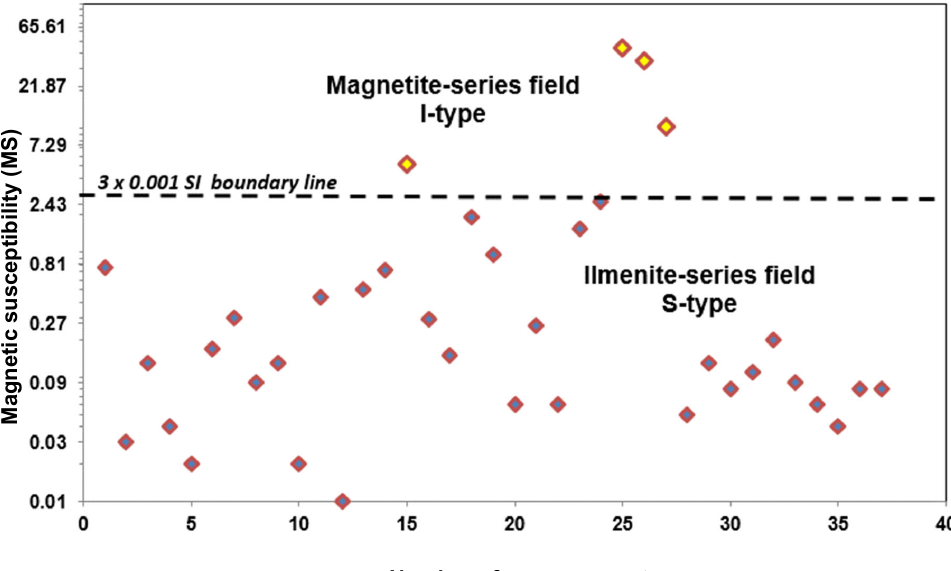
Figure 17. Spider plot of magnetic susceptibility (MS) measurements for the granitic samples collected in the study area. The dotted line sits at the value of 3 × 10 − 3 SI discriminating the I-type and S-type granites. All I-type samples plot above the line 3 × 0.001 SI and the S-type samples plot below the line 3 × 0.001SI.